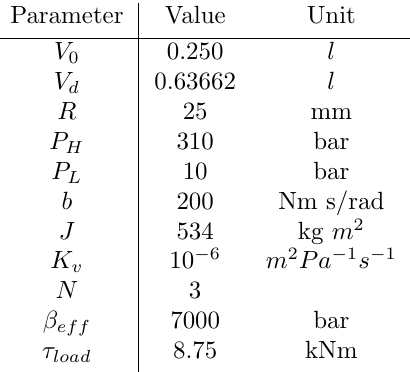
Figure 5: Equilibrium points when initial angle is π [rad]. Table 2: Parameters used in